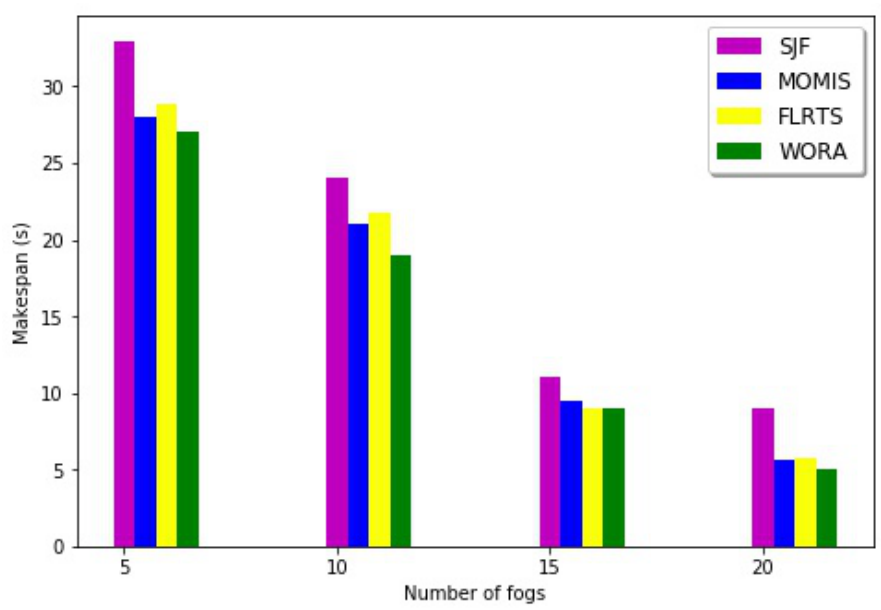
Figure 9. Computation of makespan for fog with 500 tasks.